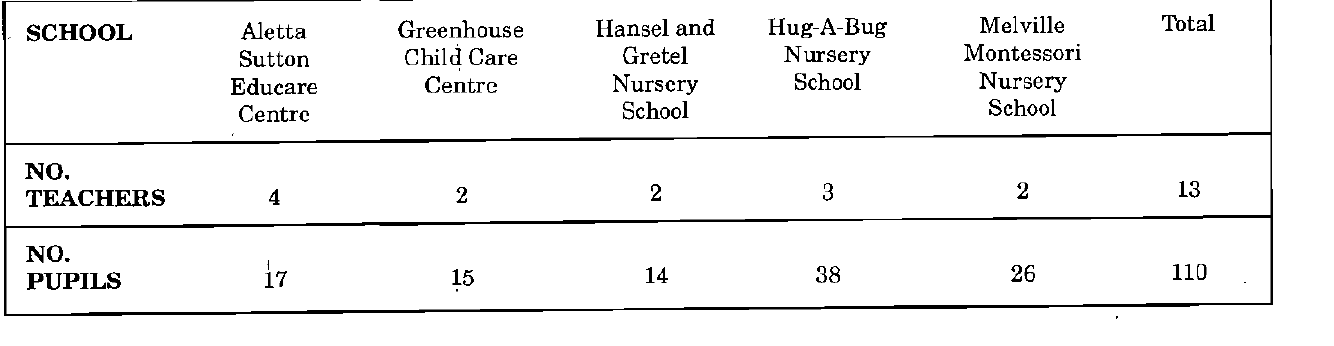
Table 2: Teacher - pupil distribution across pre-schools according to the specific sample used in this